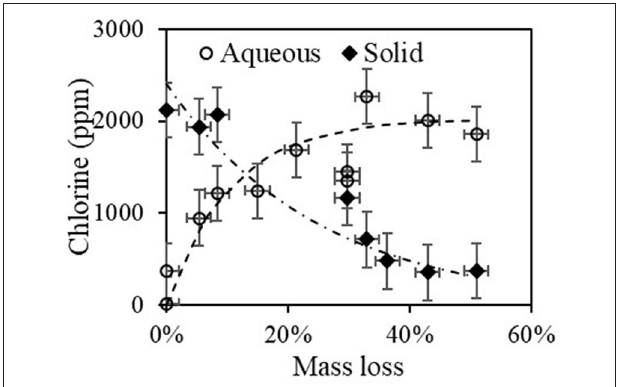
FIGURE 12 | Energy contribution of the above and under 850 µ m size fractions to the total heat content of both un-densified material and pellets as a function of mass loss.